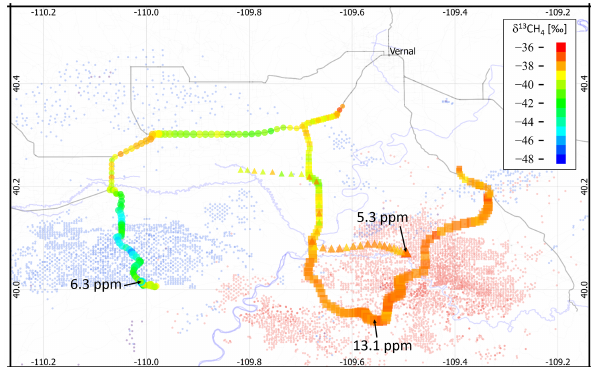
Figure 15. Map of the Uintah Basin, showing the locations of oil wells (blue) and gas wells (red). The axes are in degrees of longi- tude ( x axis) and latitude ( y axis). In addition, the gas measurements obtained from the three regional drives are plotted, where the area of the symbol is proportional to the gas concentration above the back- ground level of 1.877ppm (measured at Niwot Ridge), and the color is given by the isotope ratio, with heavy ratios in red and light ratios in blue. The highest methane concentration for each drive is indi- cated directly on the figure. Symbols correspond to the date of the measurement (circles: 1 February 2013; squares: 3 February 2013; triangles: 9 February 2013). Concentrations are highest in the pri- mary gas production area in the southeast, and the observed isotope ratio is heavy. Isotope ratios in the oil-producing areas are light- est, and the concentrations are lower. The concentrations have been scaled so that common segments of the drives have the same av- erage concentration (see text for details). Map image generated by Quantum GIS (Quantum, 2013); road and waterways data © Open- StreetMap